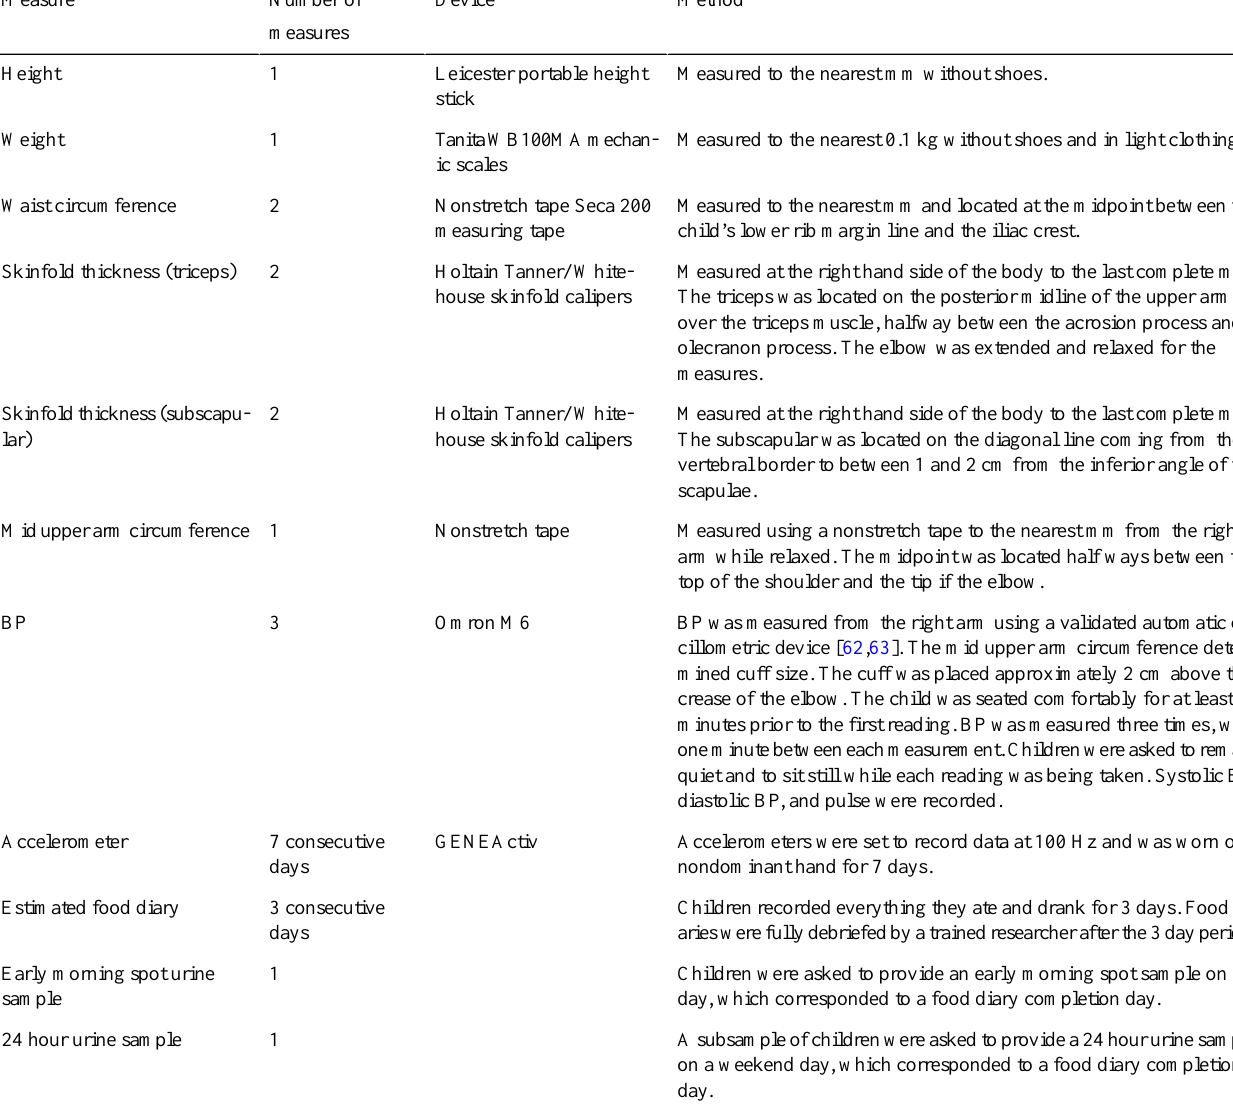
Table 1. Summary of study methods.